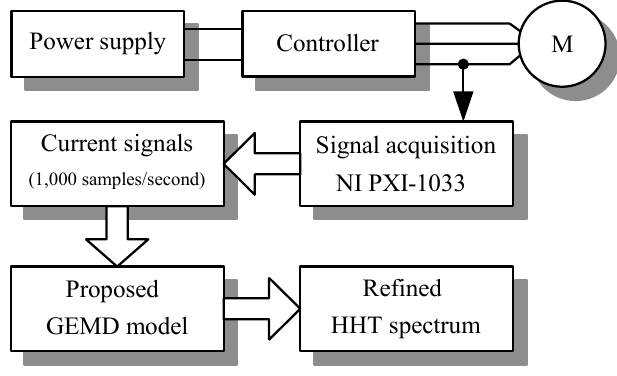
Figure 7. System diagram.